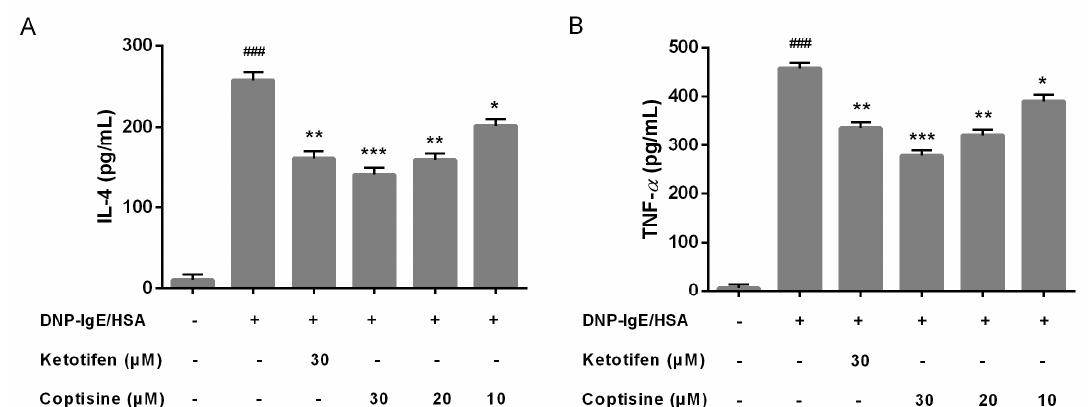
Figure 3. Effect of coptisine on IL-4, TNF- α levels in DNP-IgE/HSA-stimulated RBL-2H3 cells. Coptisine pretreated (30, 20 or 10 µM) in DNP-IgE/HSA sensitized RBL-2H3 cells. ( A ) The level of IL- 4; ( B ) The level of TNF- α . All data were expressed as the mean ± SE. * p < 0.05, ** p < 0.01, *** p < 0.001, in comparison with DNP-IgE/HSA group; ### p < 0.001 in comparison with control group.